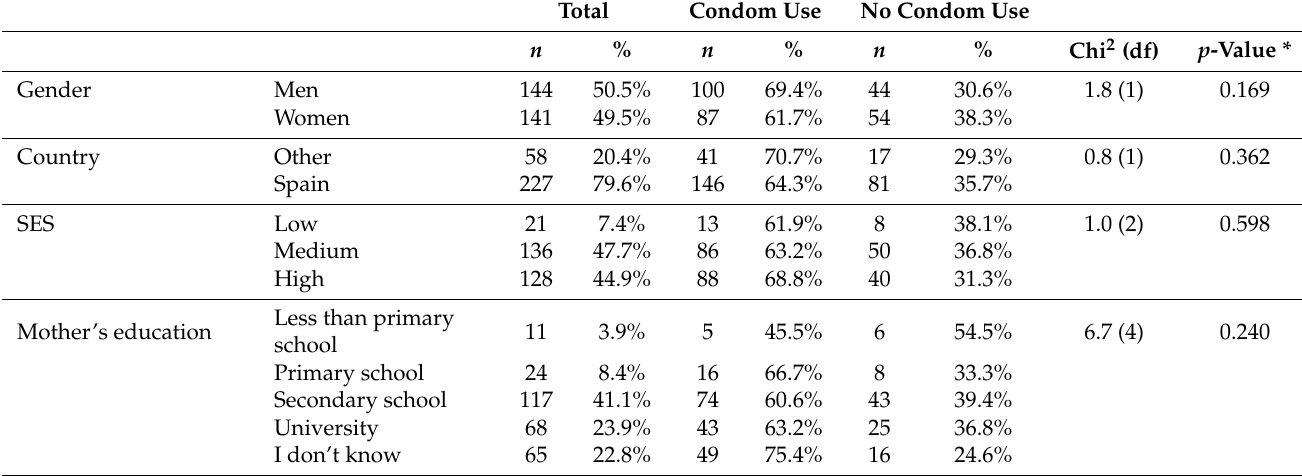
Table 1. Condom use vs. no condom use among adolescent